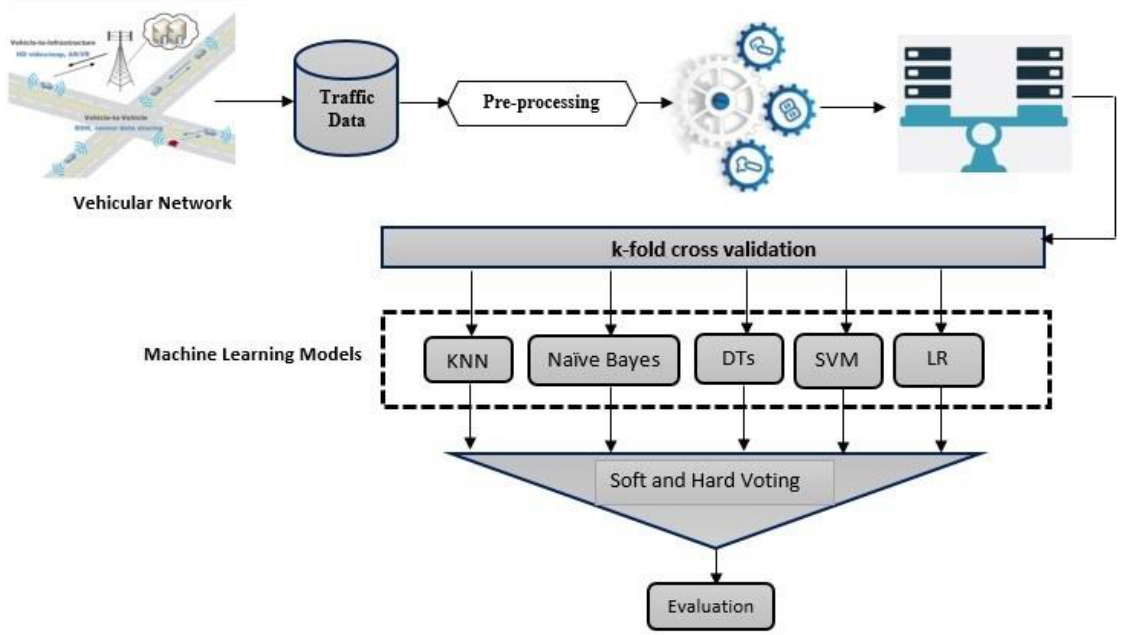
Figure 2. Proposed Framework for Sybil attack detection .